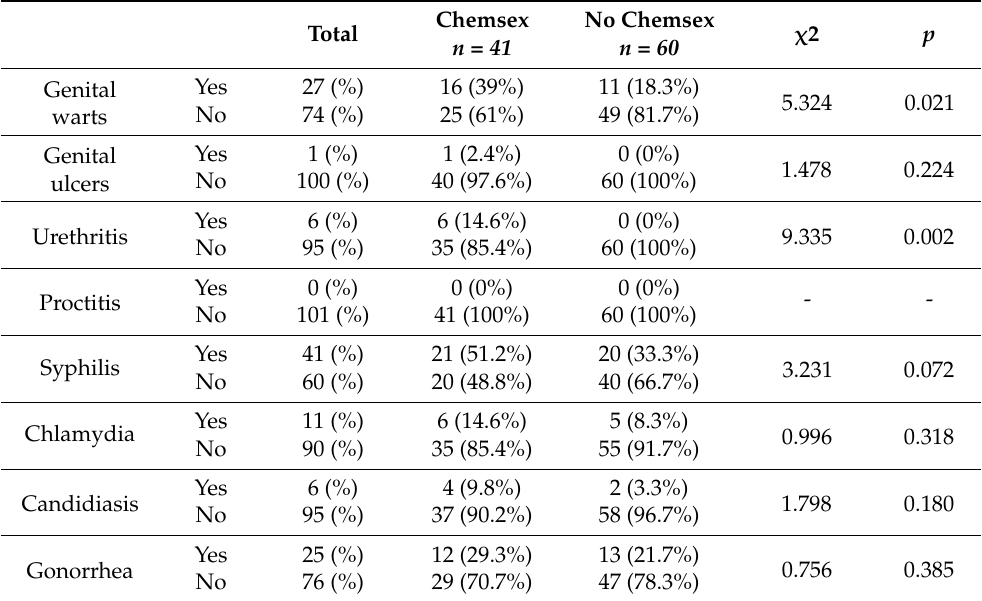
Table 6. Prevalence of STD diagnosis for all participants and for practitioners and non-practitioners of